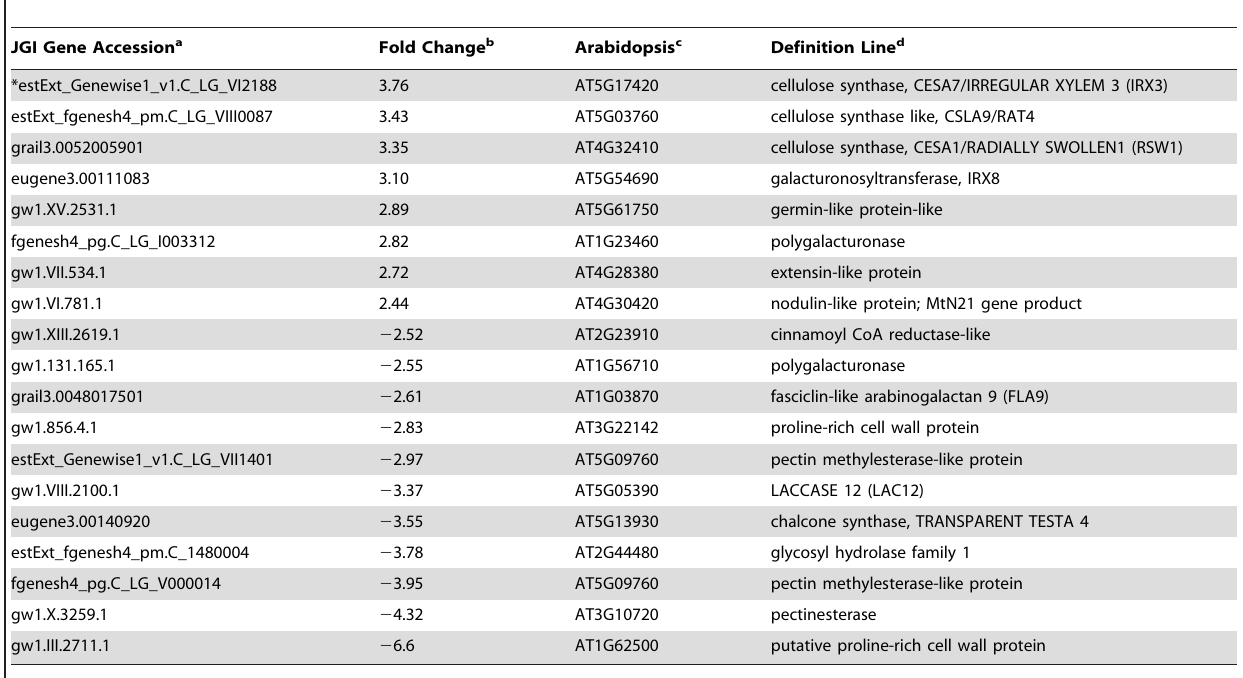
Table 3. Genes up or down-regulated in PCN transgenics involved in cell wall synthesis related